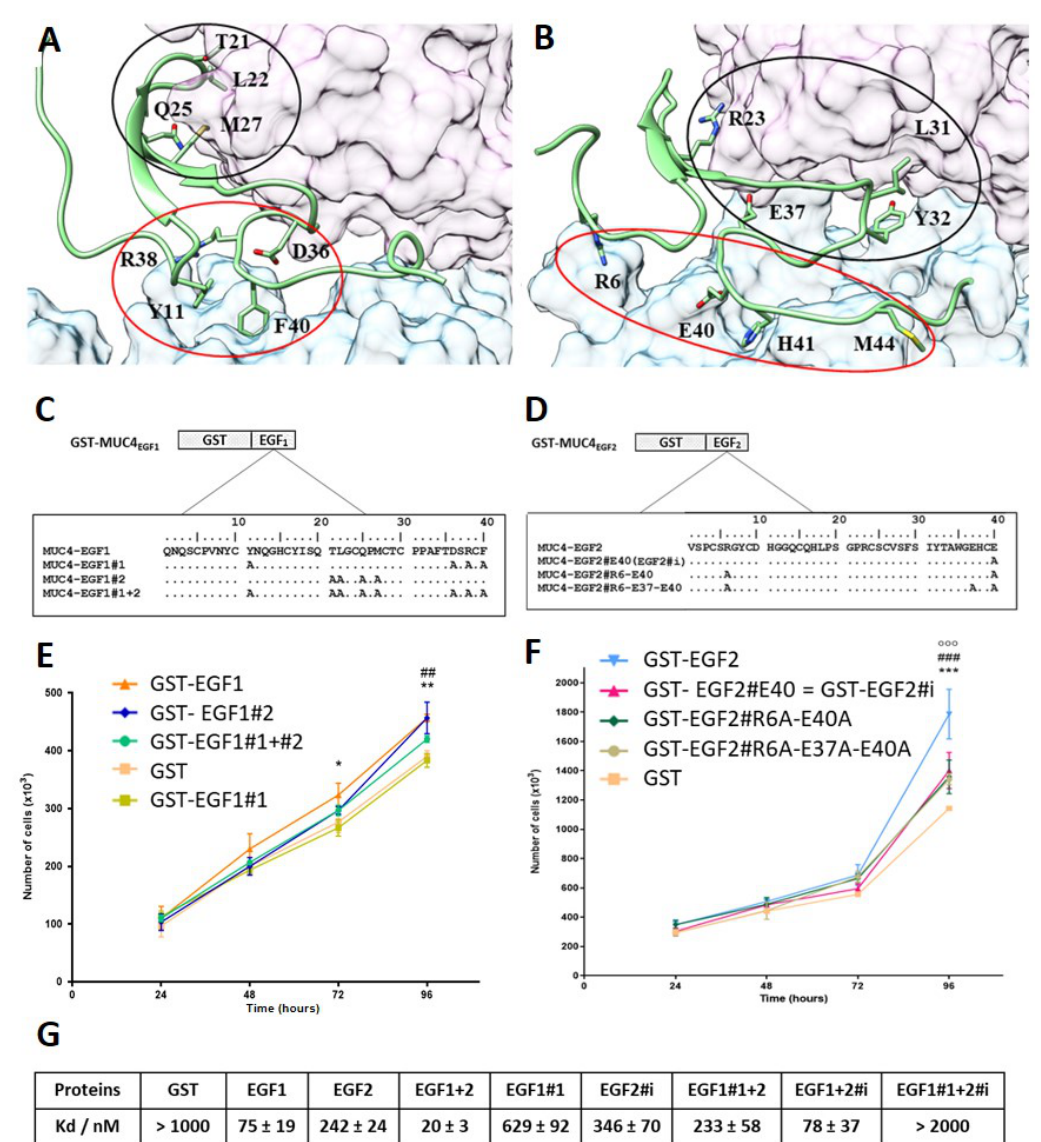
Figure 3. MD simulations of MUC4 EGF1 /HER2 and MUC4 EGF2 /HER2 complex models, hotspot identification, and effects of mutations. Intermolecular interactions within ( A ) MUC4 EGF1 /HER2 and ( B ) MUC4 EGF2 /HER2 complexes after MD simulations. The molecular surface maps of domains I and III of HER2 are shown in pink and cyan, respectively. MUC4 EGF domains appear in green, and cluster 1 and cluster 2 are surrounded in red and black, respectively. The illustration was made using UCSF Chimera v1.10.2. The aa sequences of wt and mutated GST-MUC4 EGF1 ( C ) and GST- MUC4 EGF2 ( D ) domains. The aa residues identified by MD as key binding hotspots were mutated into an alanine residue as indicated. EGF1#1: mutation of Y11, D36, R38, and F40; EGF1#2: mutation of T21, L22, Q25, and M27; EGF1#1 + #2: mutation of Y11, T21, L22, Q25, M27, D36, R38, and F40; EGF2#R6-E37-E40: mutation of R6, E37, and E40; EGF2#R6-E40: mutation of R6 and E40; EGF2#E40 (EGF2#i): mutation of E40. ( E ) Measurement of Panc1 cell proliferation after cell treatment with wild-type GST-EGF1, GST-EGF1#1, GST-EGF1#2, and GST-EGF1#1 + #2 at 1 µ g/mL. * Statistically significant difference between GST-EGF1 and GST-EGF1#1; # statistically significant difference between GST-EGF1#2 and GST-EGF1#1. ( F ) Measurement of Panc-1 cell proliferation after cell treatment with wild-type GST-EGF2, GST-EGF2#R6A-E37A-E40A, GST-EGF2#R6A-E40A, and GST-EGF2#E40A (EGF2#i) at 1 µ g/mL. Statistically significant differences between GST-EGF2 and GST-EGF2#i are indicated; * p < 0.05, ** , ## p < 0.01, and *** , ###, ooo p < 0.005. ( G ) Measurement of binding affinities between fluorescent tagged HER2 and GST-MUC4 EGF1 (EGF1), GST-MUC4 EGF2 (EGF2), GST-MUC4 EGF1+2 (EGF1+2), GST-MUC4 EGF1#1 (EGF1#1), GST-MUC4 EGF2#i (EGF2#i), GST-MUC4 EGF1#1+2 (EGF1#1+2), GST-MUC4 EGF1+2#i (EGF1+2#i), GST-MUC4 EGF1#1+2#i (EGF1#1+2#i), or GST alone (negative control), using